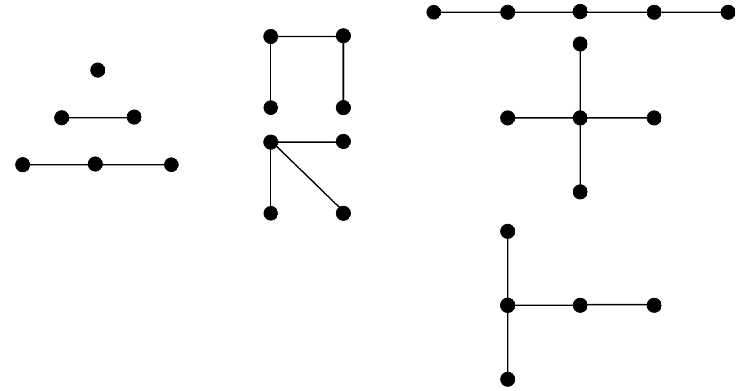
Figure 2 . The list of trees up to 5